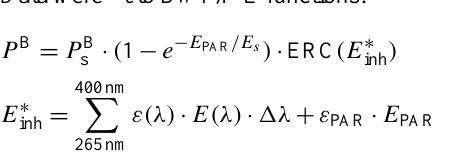
Table 1. Filter configuration for the 12 spectral treatment groups of the photoinhibitron as used in this study.